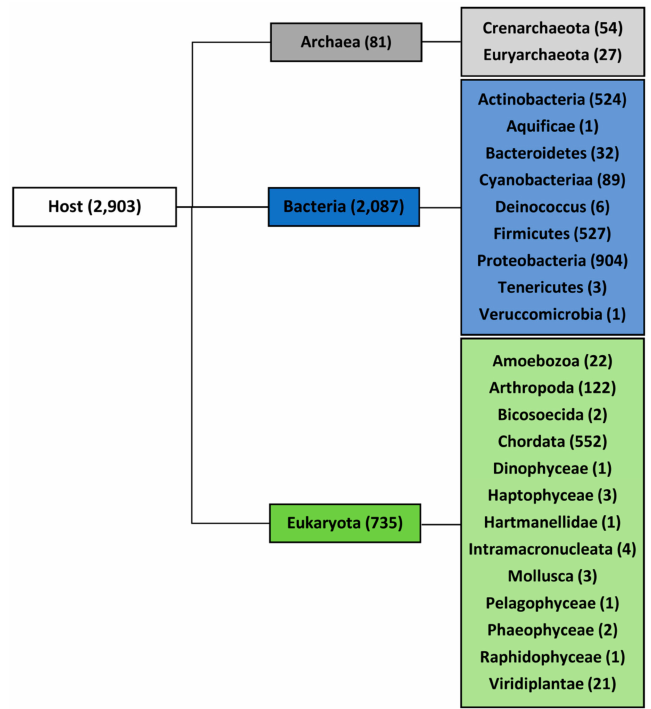
Figure 1. Full set of viral genomes divided according to host. The number of accessible unique genomes for each domain and group is shown in brackets. Table 1. Total number of putative G-quadruplex-forming sequences (PQS) and their resulting frequencies per 1000 nt in all 2903 viral genomes and host categories, grouped by G4Hunter score. Frequencies were calculated as the total number of PQS in each category divided by the total length of all analyzed sequences, multiplied by 1000 and normalized by the number of viruses infecting one genus. G4Hunter Score PQS Frequency per 1000 nt All Archaea Bacteria